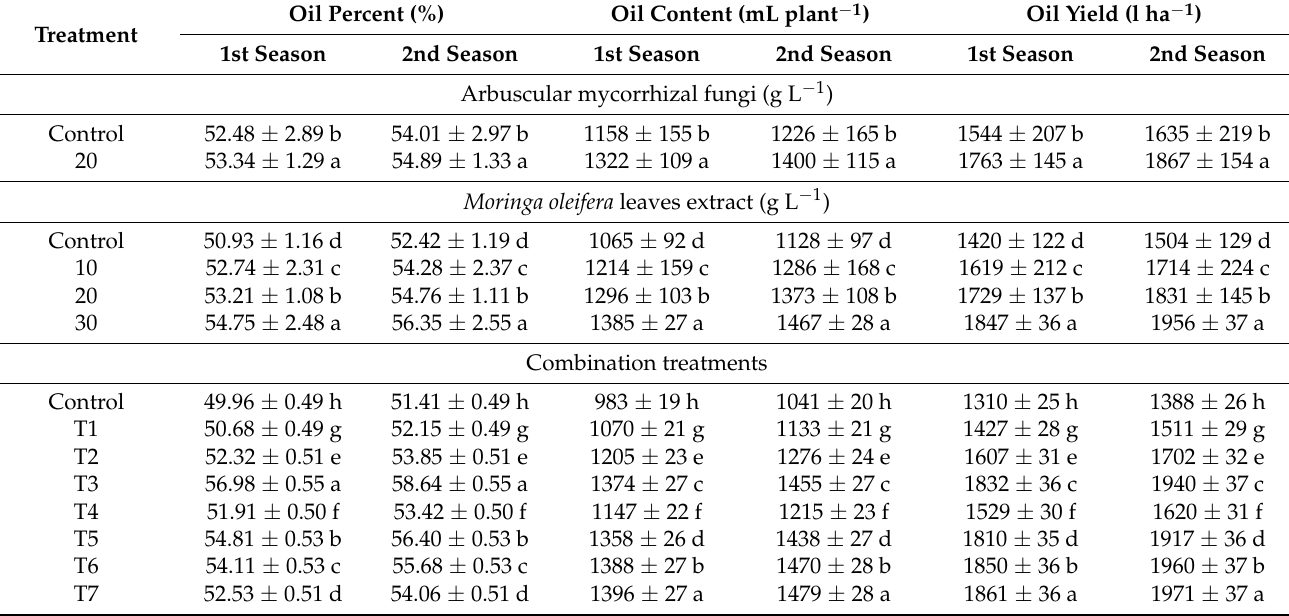
Data are mean value ± SE. Means in columns followed by the same letter are not statistically different at the 0.05 significance